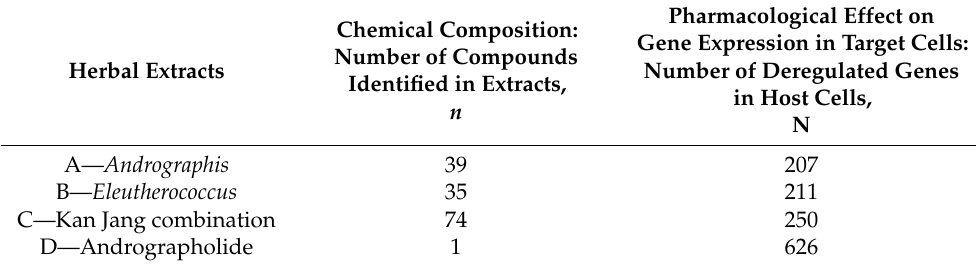
Table 2. The number of compounds ( n ) identified in the Andrographis extract (A), Eleutherococcus extract (B), and KanJang (C), and their pharmacological effect expressed as a number of deregulated genes (N) in host